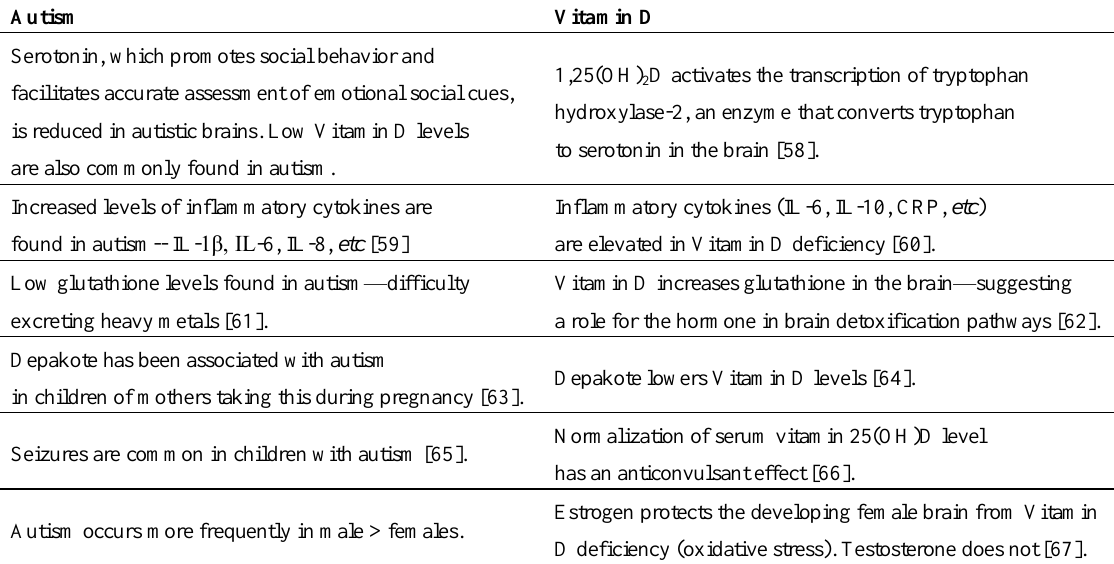
Table 2. Commonalities between Autism and Vitamin D